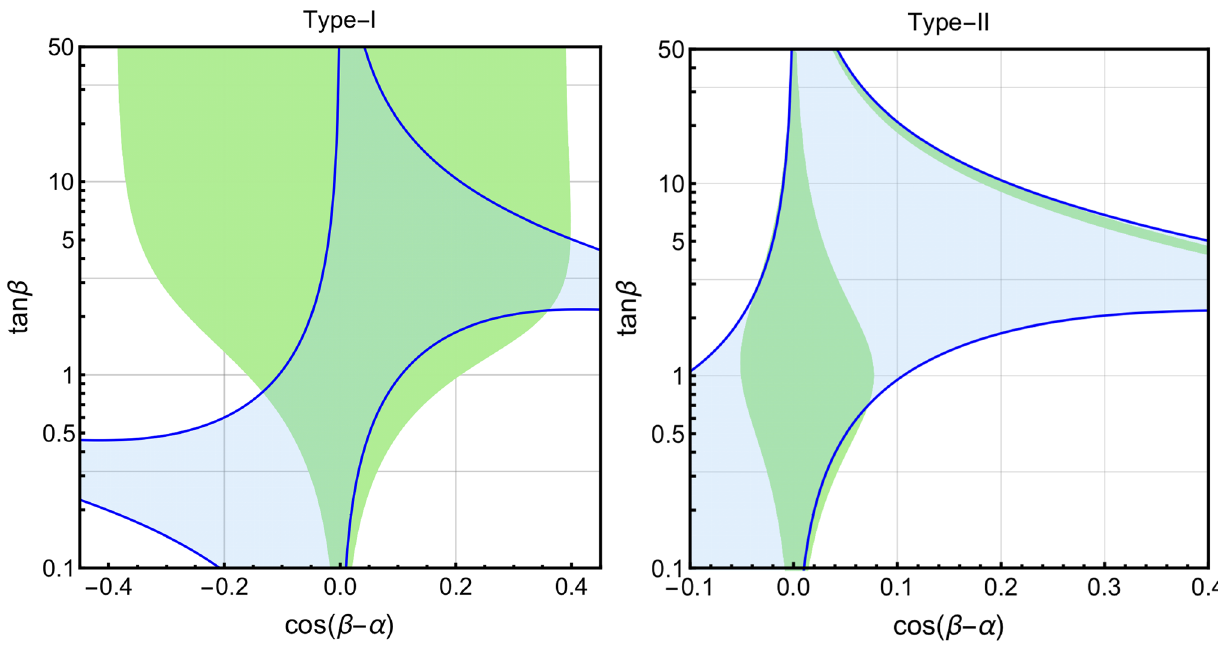
Fig. 2 Allowed regions by SM-like Higgs precision measurements (green) and theoretical constraints (blue) in the cos (β − α) -tan β plane. The left is for the Type-I and right for the Type-II 2HDM